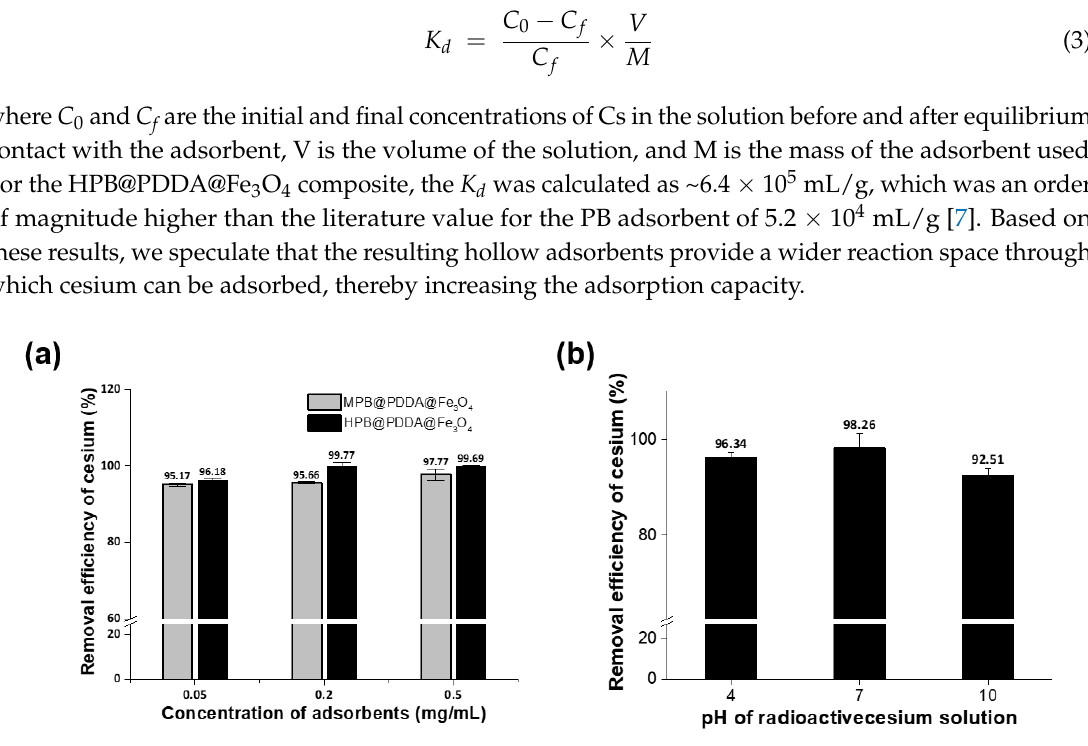
Figure 6. ( a ) Removal efficiency of 137 Cs by MPB@PDDA@Fe 3 O 4 and HPB@PDDA@Fe 3 O 4 composites and ( b ) influence of pH on the uptake of 137 Cs by HPB@PDDA@Fe 3 O 4 composite.